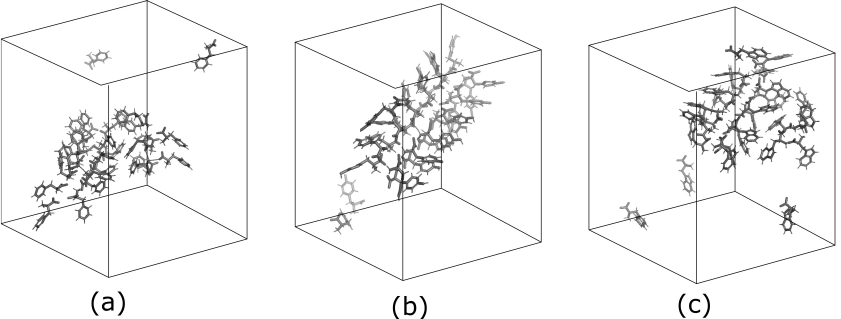
Figure 4. Typical snapshots of the systems taken at the simulation time 500 ns. ( a ) 27 Phe molecules, ( b ) 27 Tyr molecules, and ( c ) 27 Trp